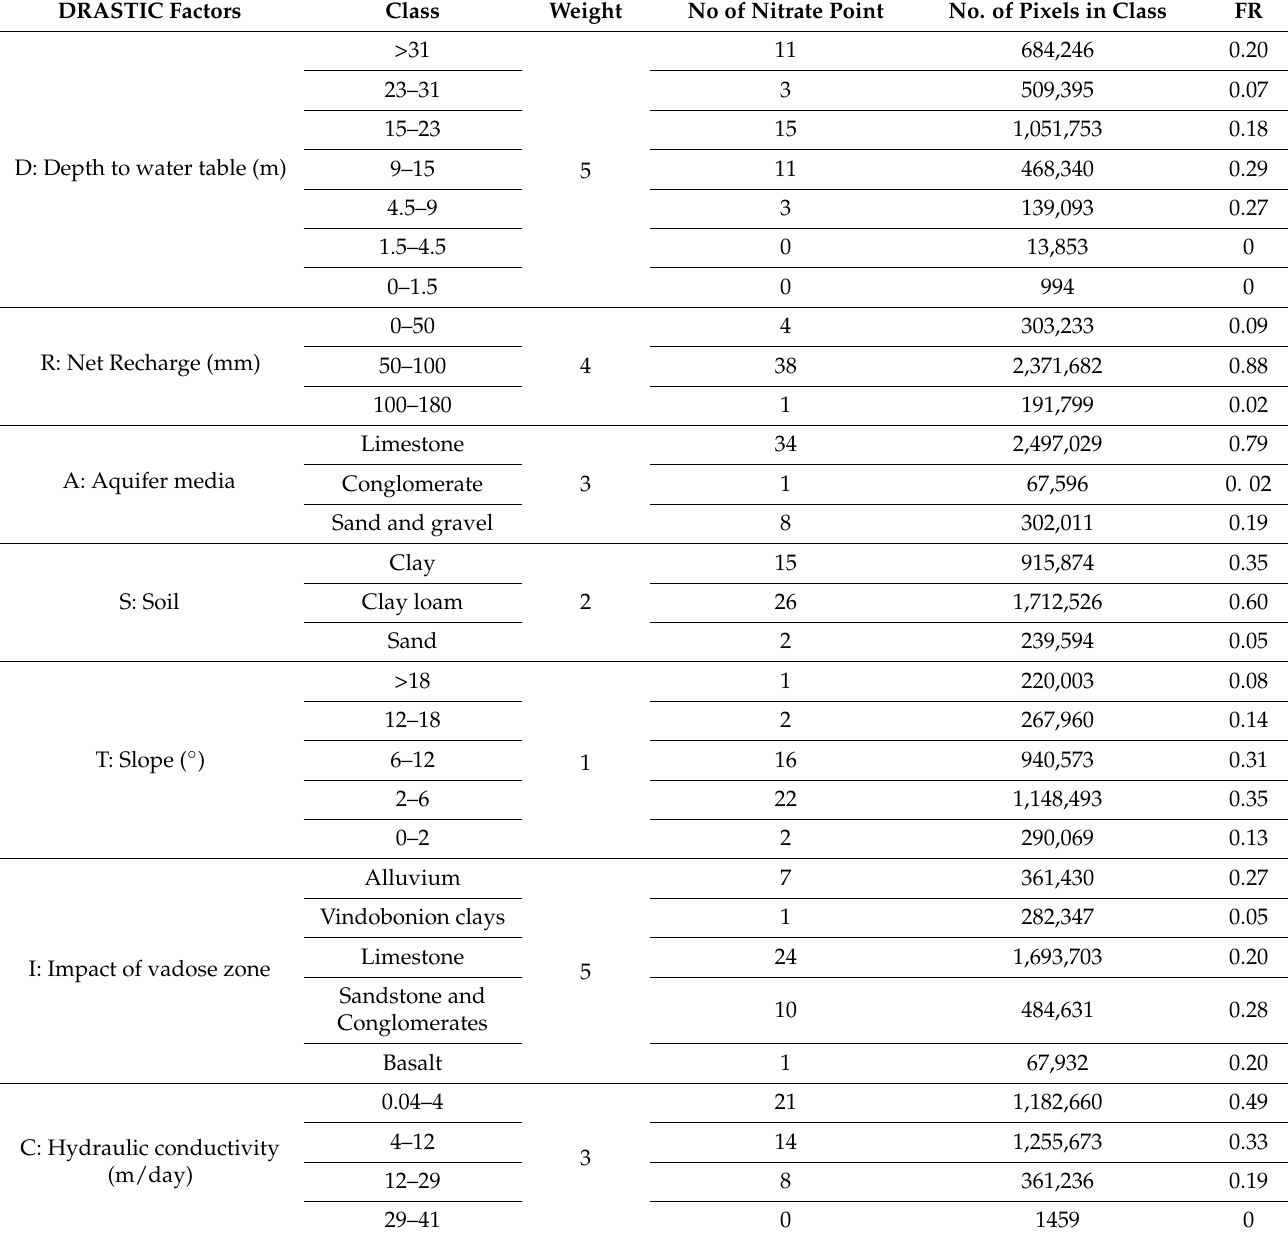
Table 1. Frequency ratio of DRASTIC